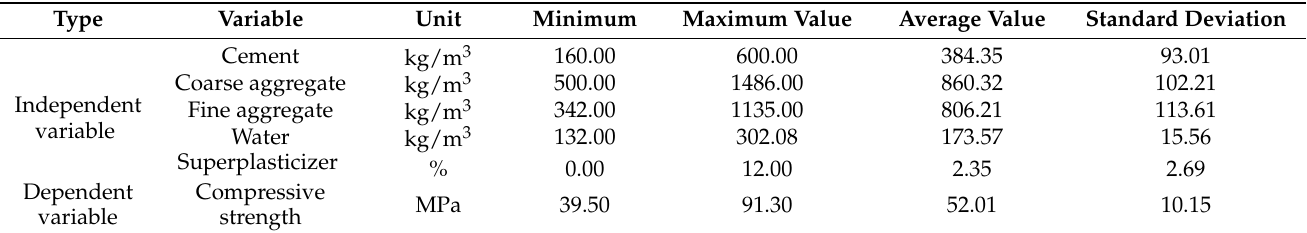
Table 4. Statistics of the HSC dataset (data source: [47]).